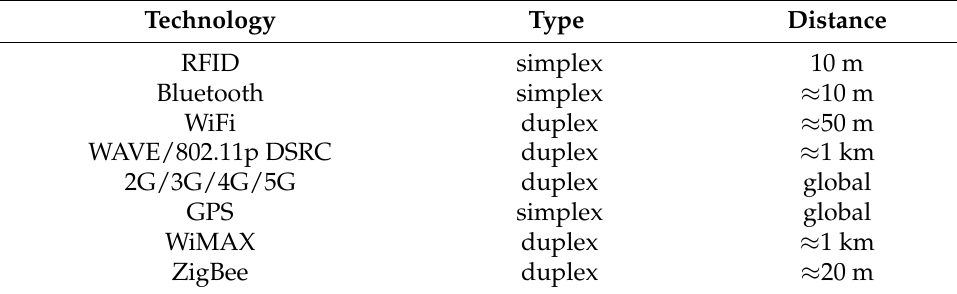
Table 1. VANET communication